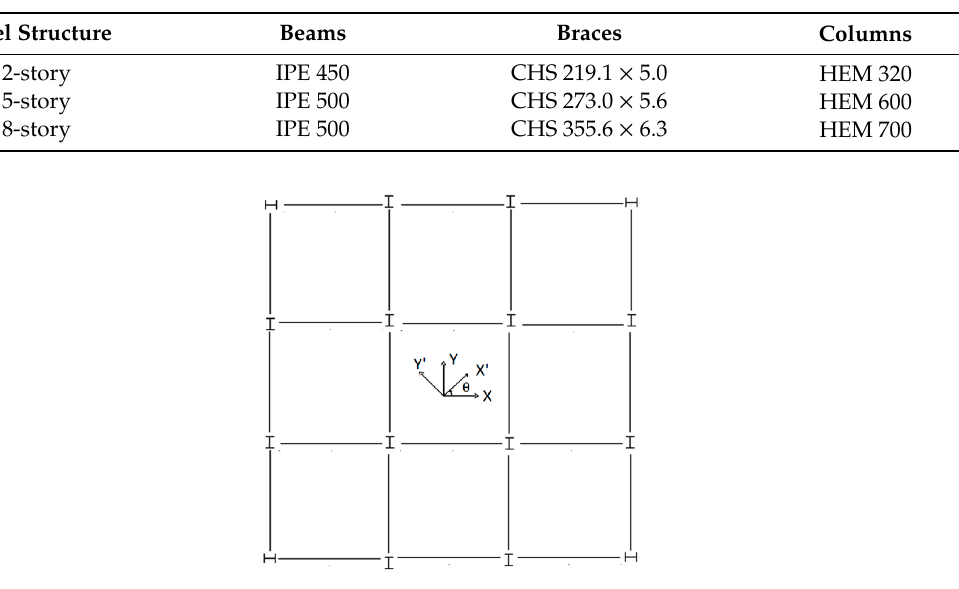
Figure 2. The orientation of columns for the 2-, 5-, and 8-story steel buildings.